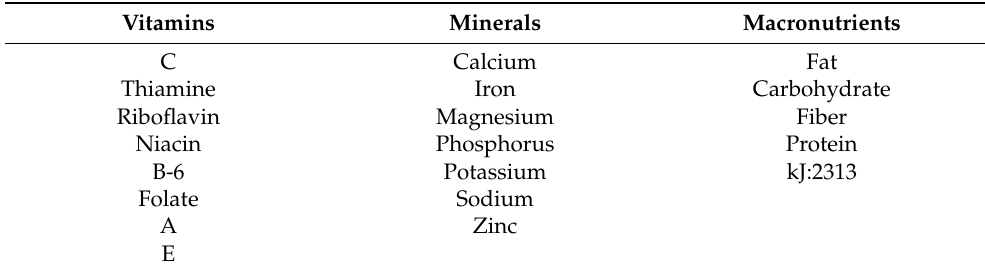
Table 7. Examples of vitamins, minerals and macronutrients produced by C. sativa L. seeds [50].